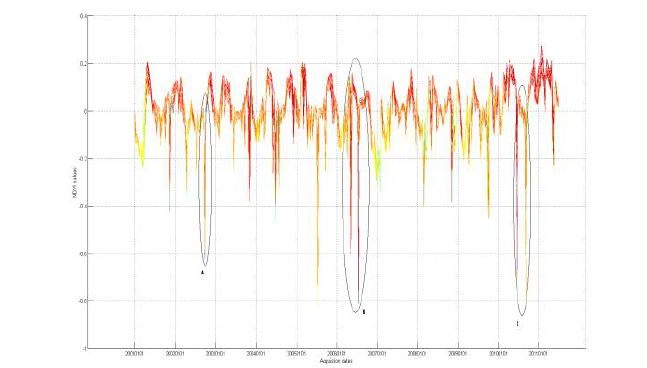
Figure 7-A. Seasonal variations removed 2D NDVI time